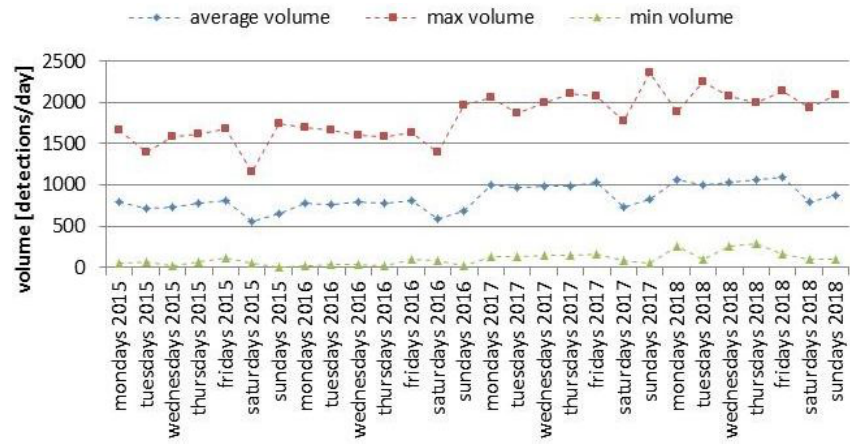
Figure 13: Number of detections per consecutive days of the week of 2015-2018 period for Route 3